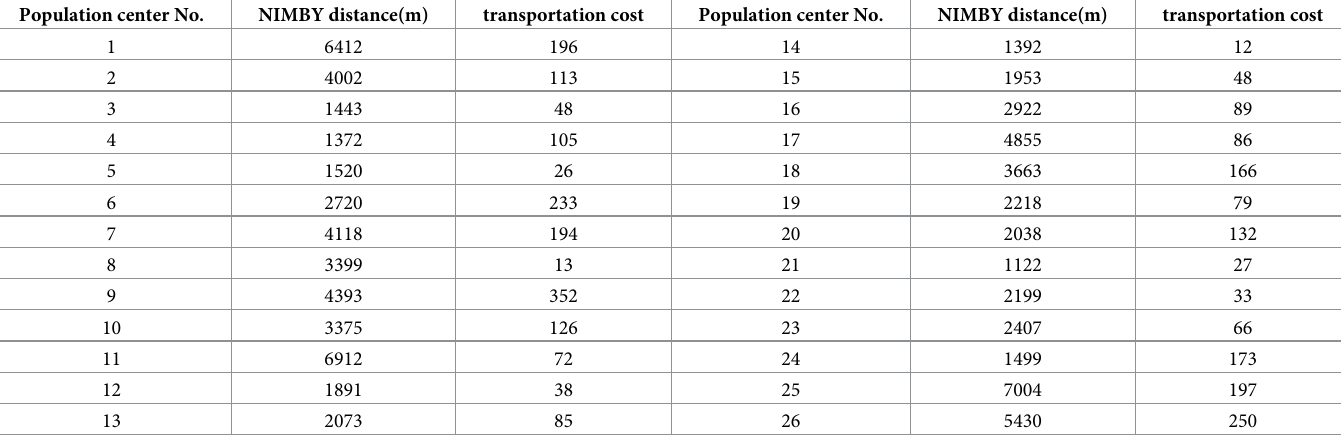
Table 6. The NIMBY distance and waste transportation cost of population centers in scheme #24 under Model 3. Population center